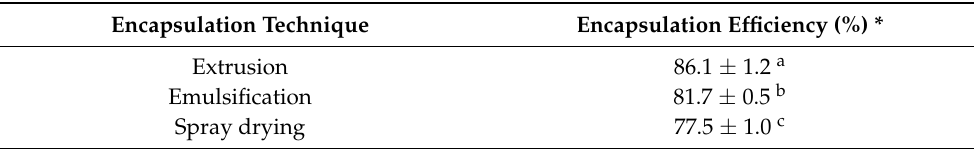
Table 1. Encapsulation efficiency of VUPF506 into ALG–WP–CNT